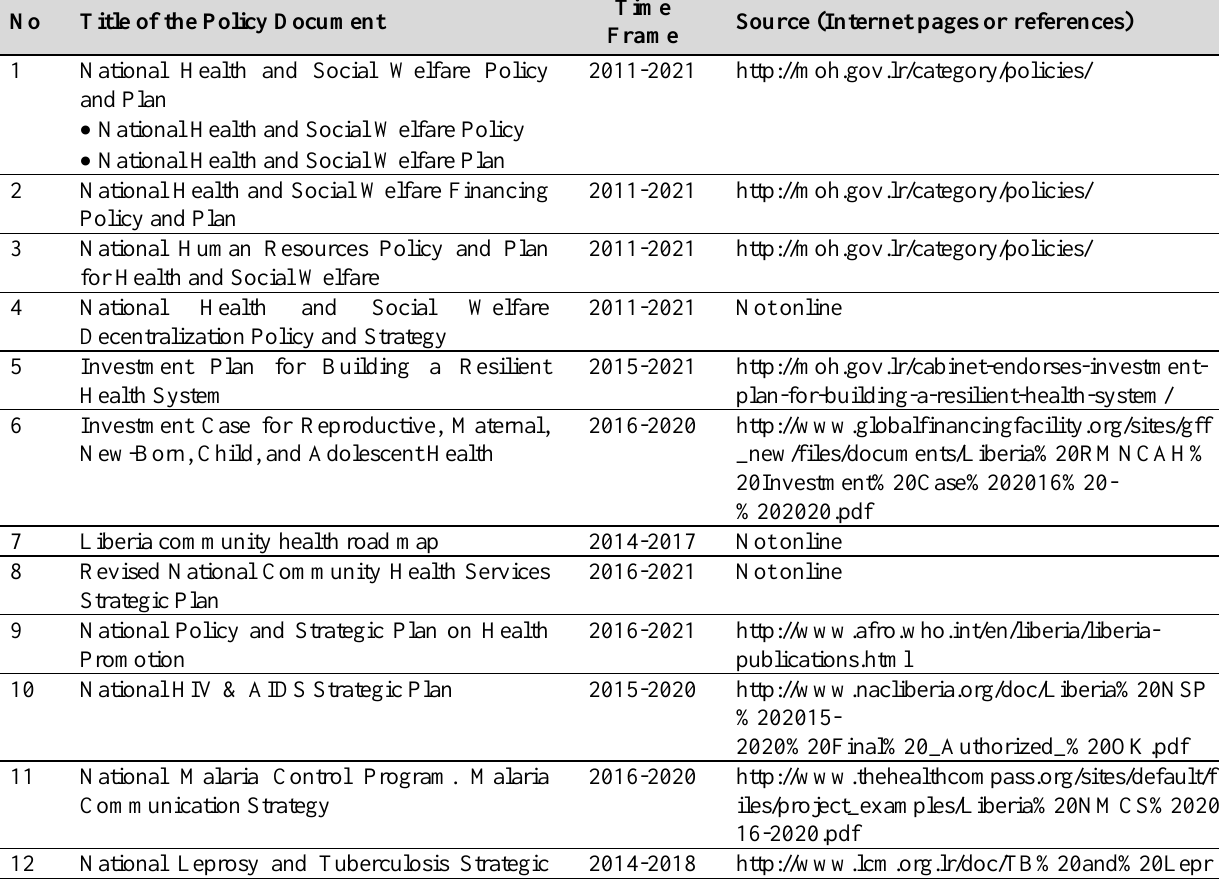
Table 1. Liberian policy documents embracing